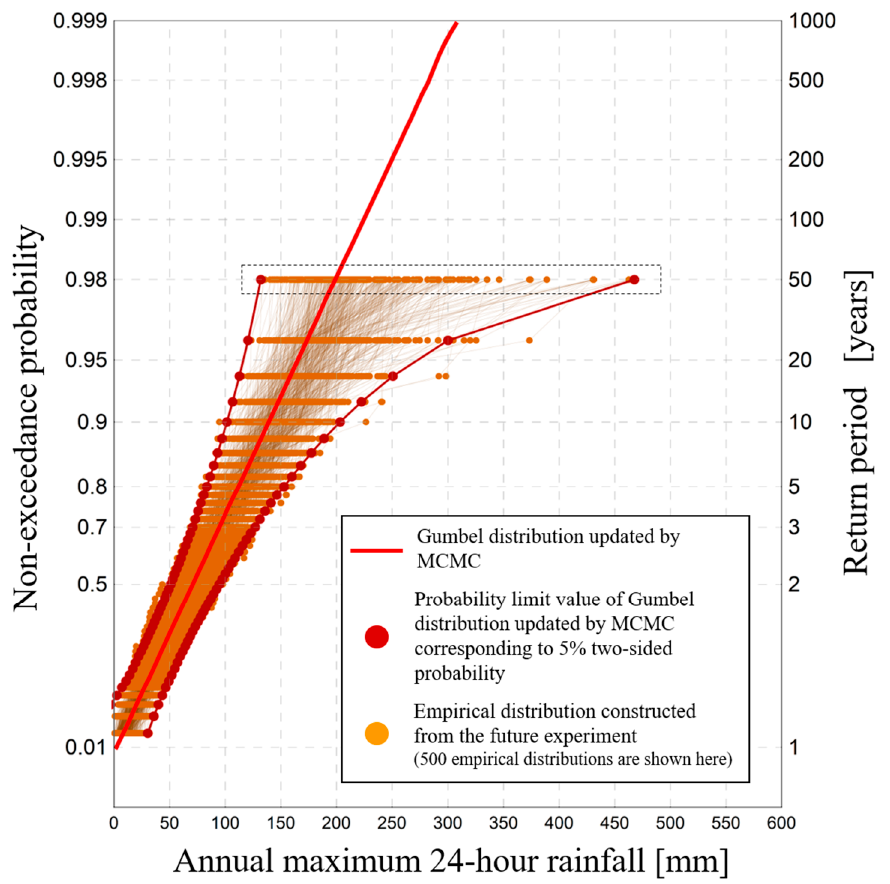
Figure 18. Gumbel distribution for future climate (predicted distribution of Gumbel distribution fitted to analytical data), with probability limit values of this Gumbel distribution with 5% two-sided probability and 500 empirical distributions constructed from resampled samples of future experiment data.